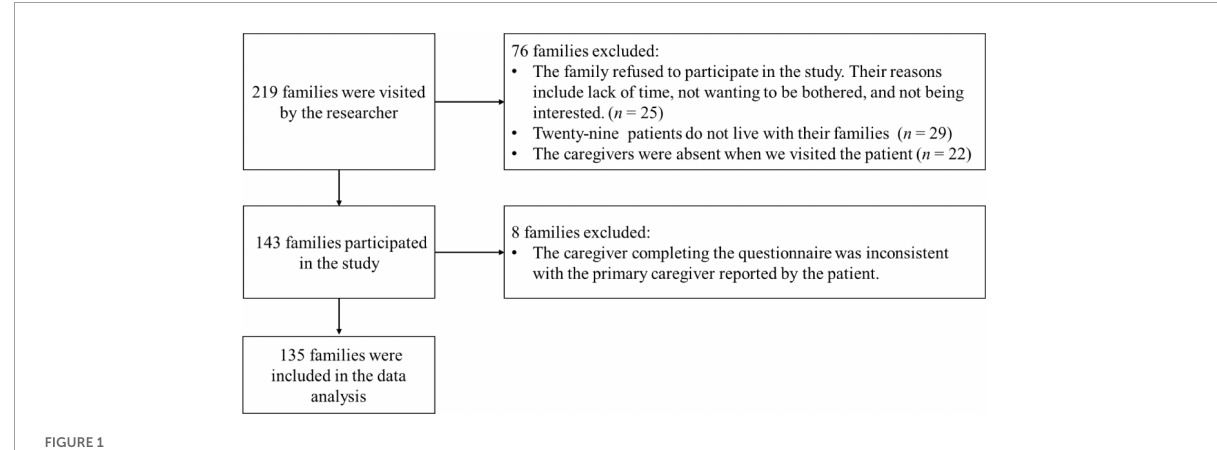
FIGURE1 Flowchart of the participants